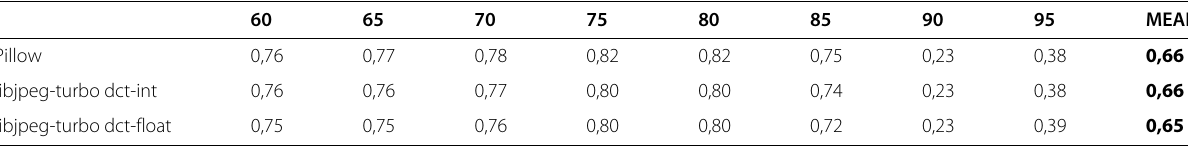
Table 7 Accuracy obtained employing different JPEG implementations with QF 2 = 90 60